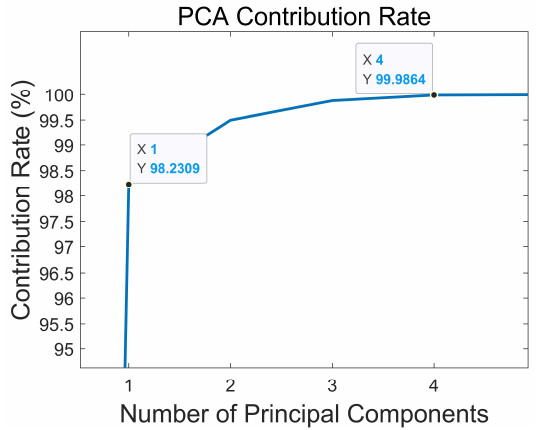
Figure 4. The contribution rate of the principal component vector.